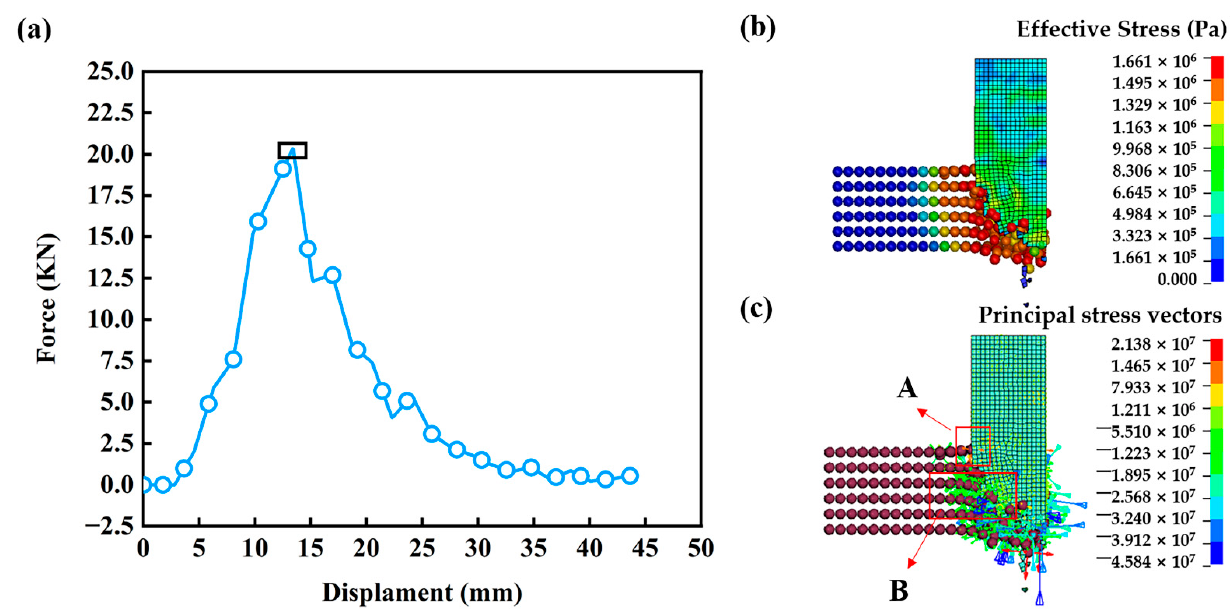
Figure 8. ( a ) The variation of reaction force on the contact surface of the target plate with the depth of the invasion side, ( b ) the equivalent stress distribution diagram, and ( c ) the main stress vectors at the maximum reaction force.